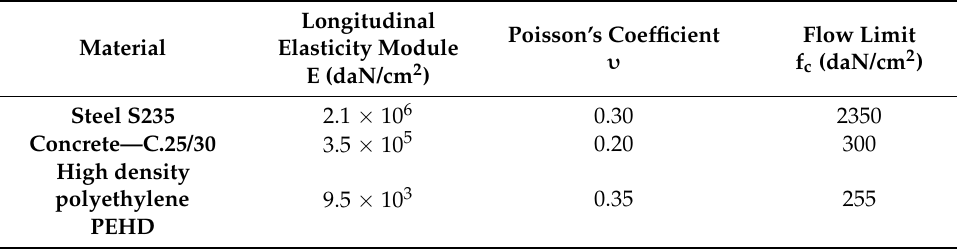
Table 1. Mechanical characteristics of